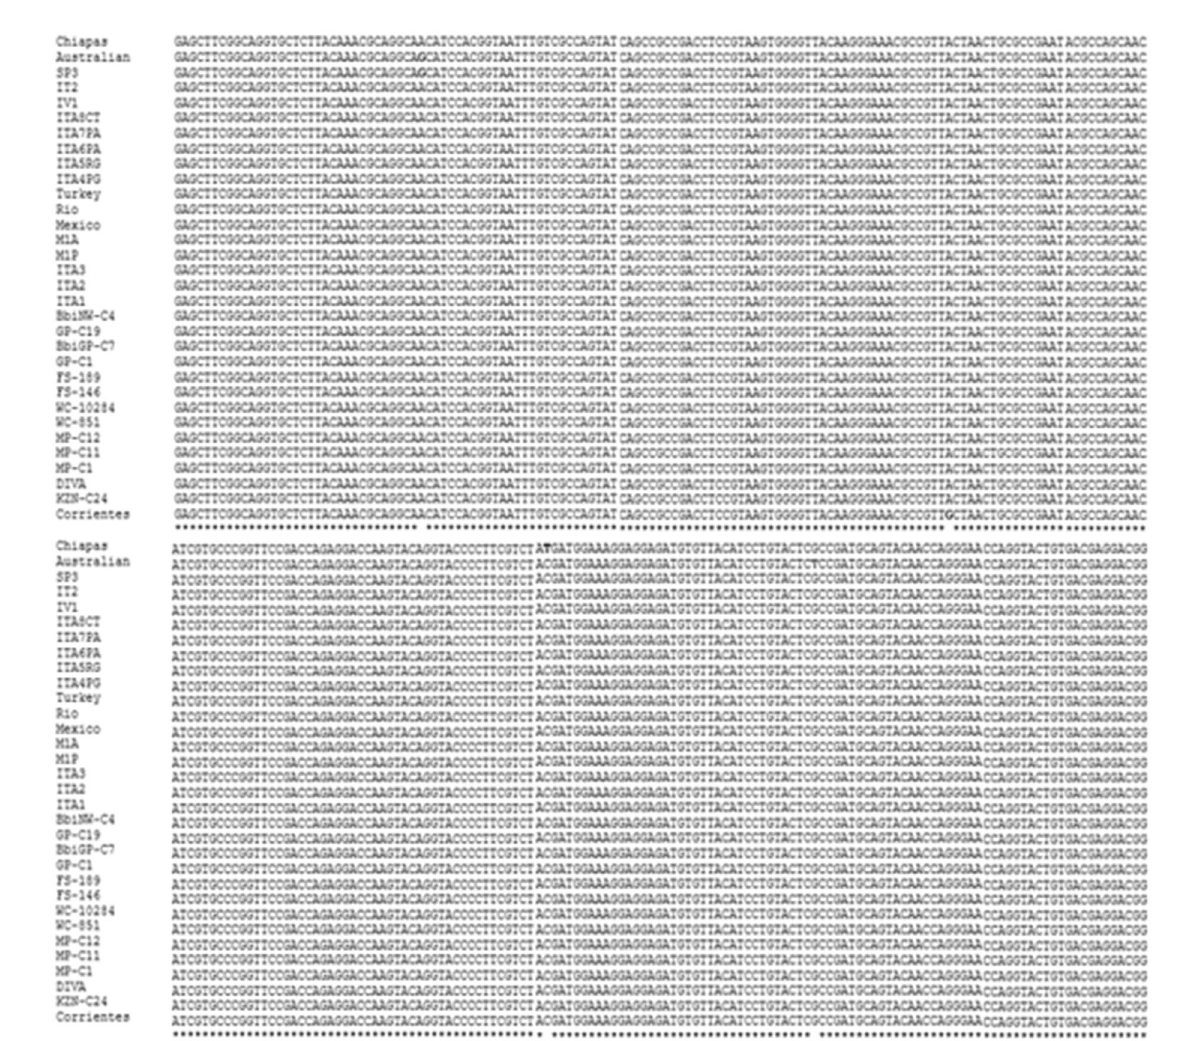
FIGURE1 Multiple alignment of a conserved region of the ama-1 gene of the strains of Babesia bigemina reported in the GenBank. The asterisks ( * ) show the conserved regions, the blank spaces show the nucleotide differences of the analyzed sequences, and the colored letters show that the nucleotides vary in one or two